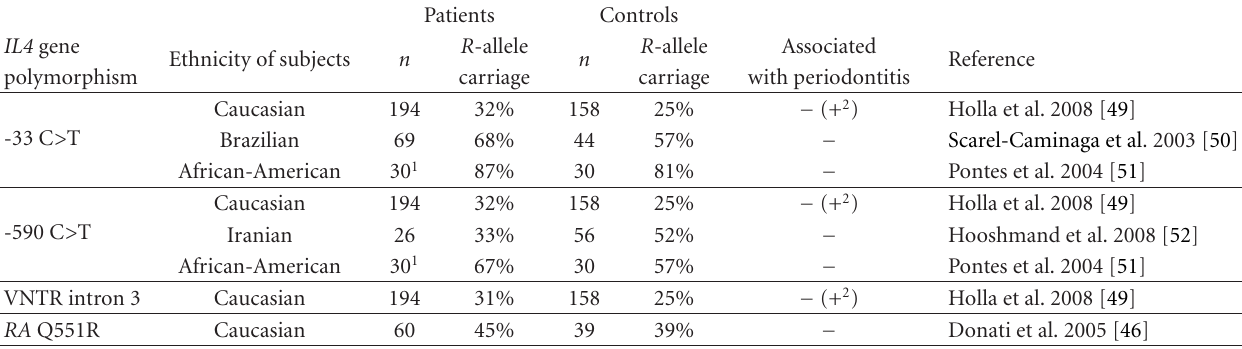
Table 6: IL4 and IL4RA gene polymorphisms and carriage of the Rare ( R )-allele in case-control studies, and association with chronic susceptibility to